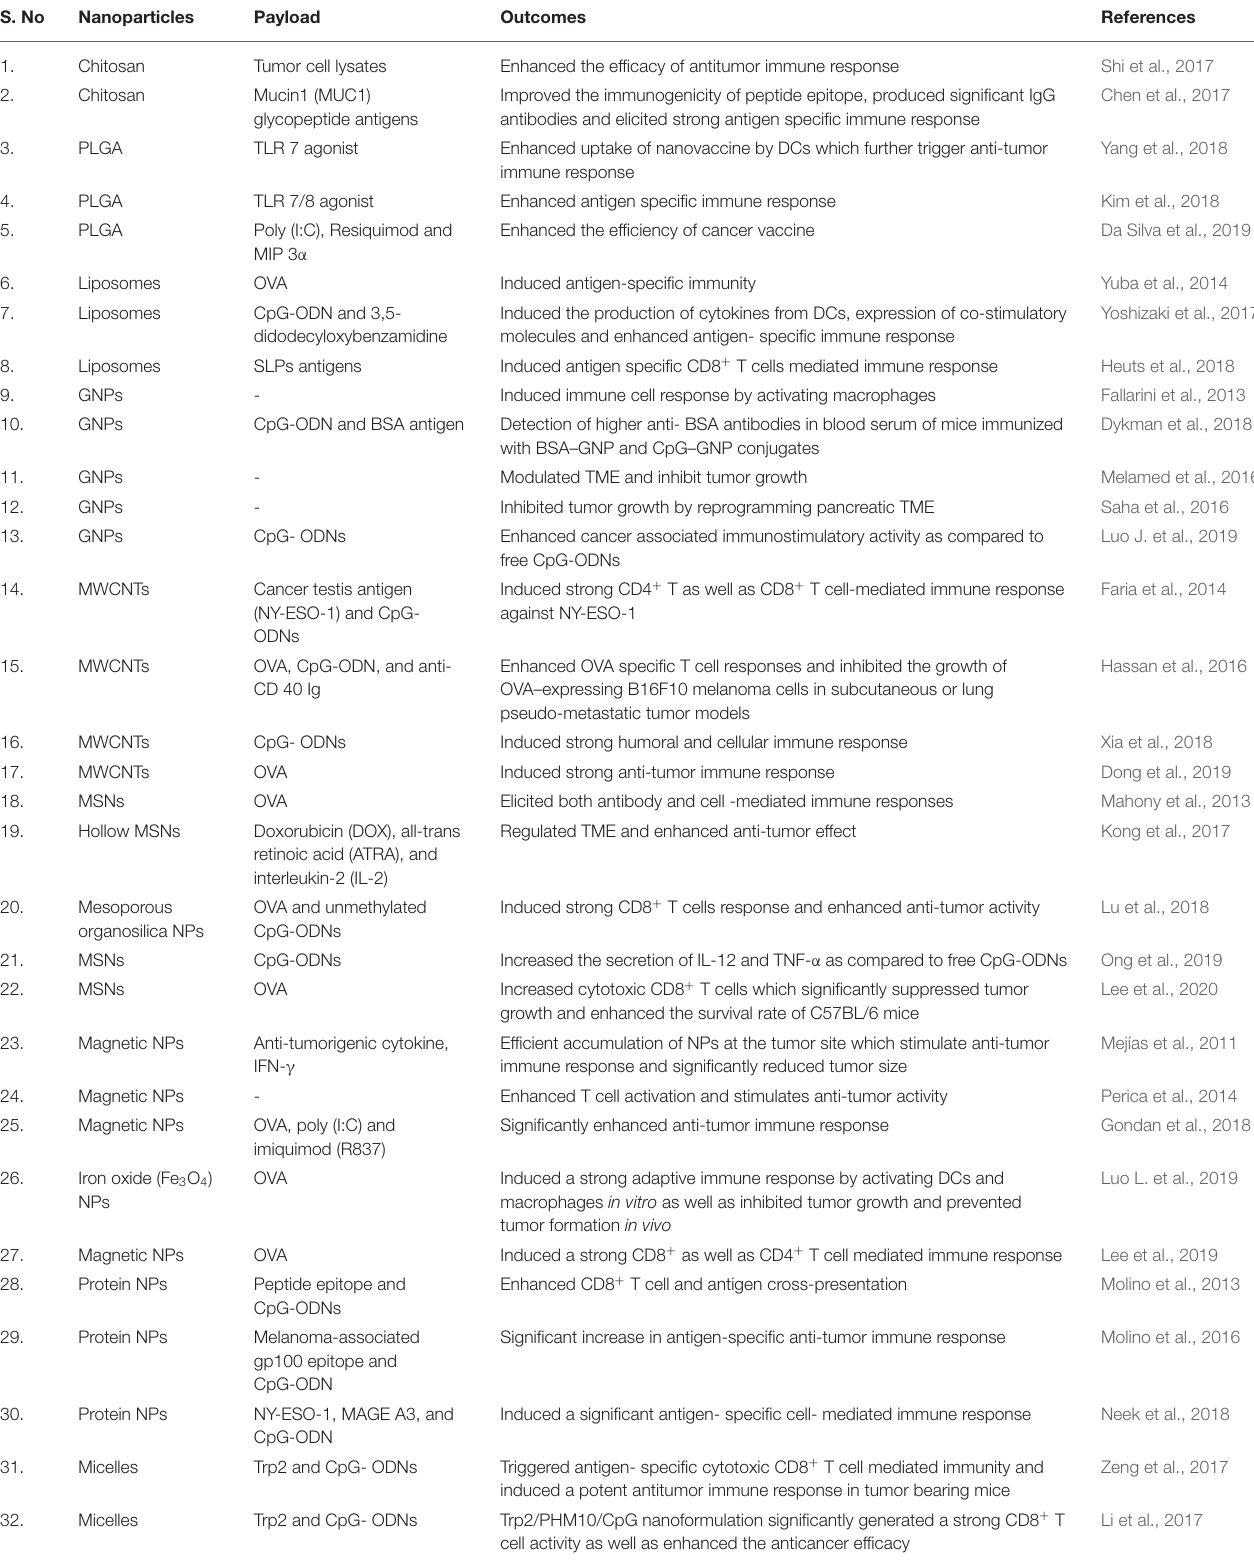
TABLE 1 | Nanoparticle-based immunostimulatory effect for cancer therapy. S.